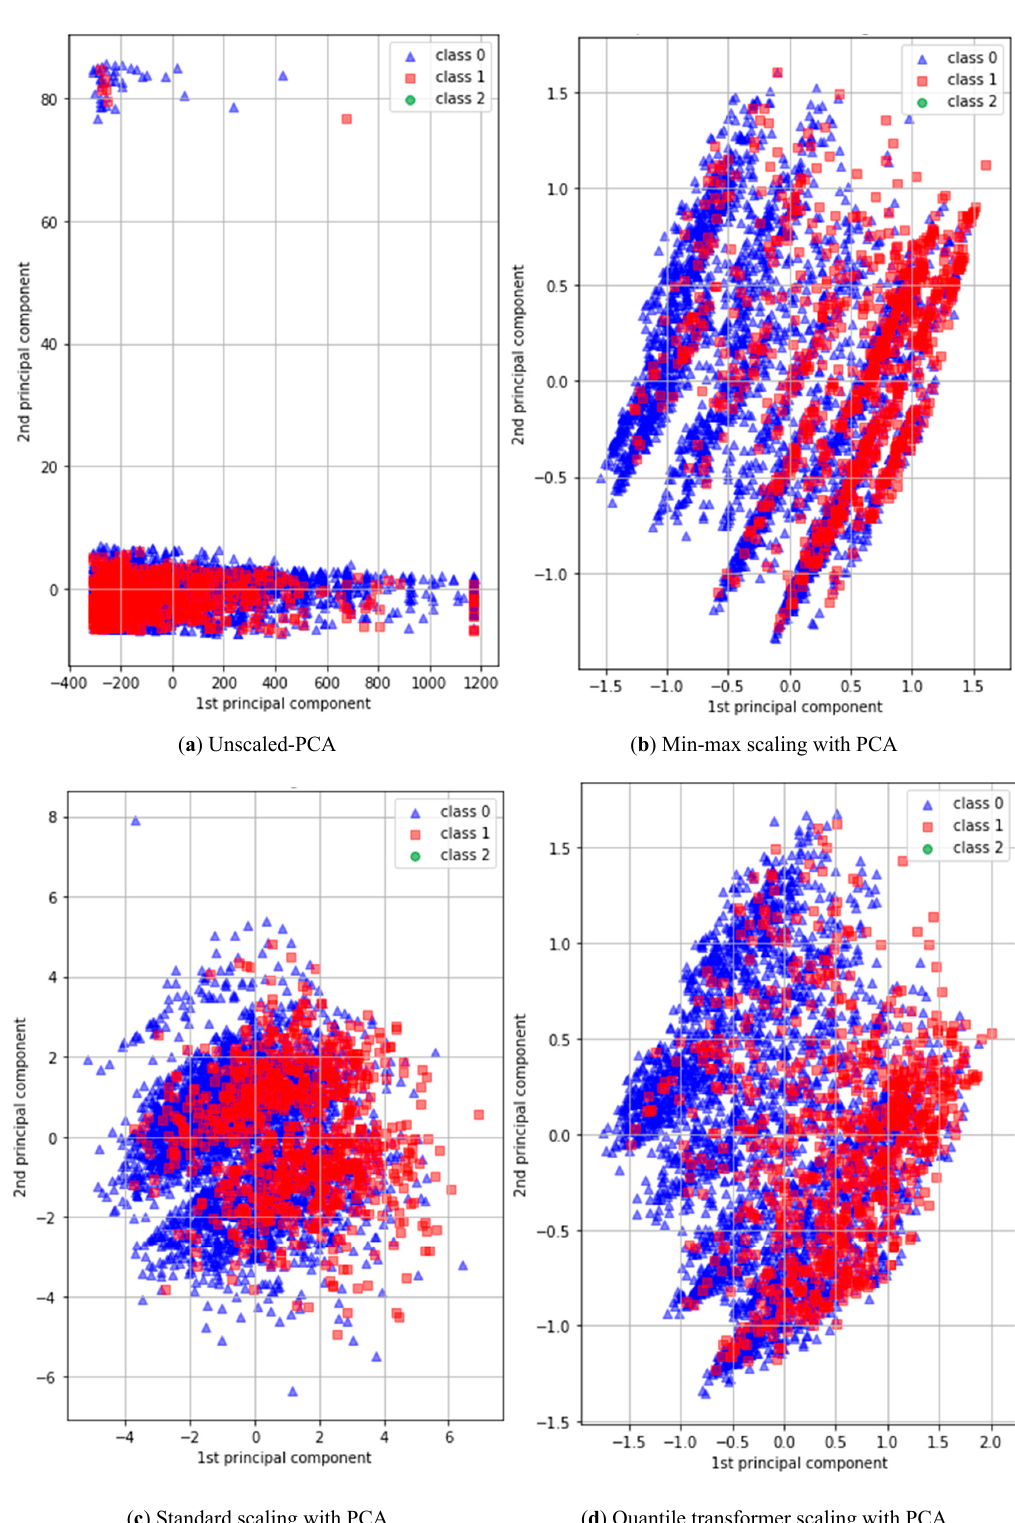
Figure 3. Two-dimensional plots of first and second principal components. ( a ) Unscaled-PCA. ( b ) Min-max scaling with PCA. ( c ) Standard scaling with PCA. ( d ) Quantile transformer scaling with